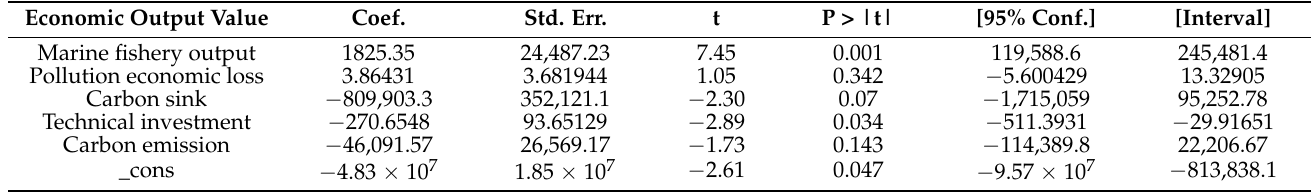
Table 11. Multiple linear regression analysis.